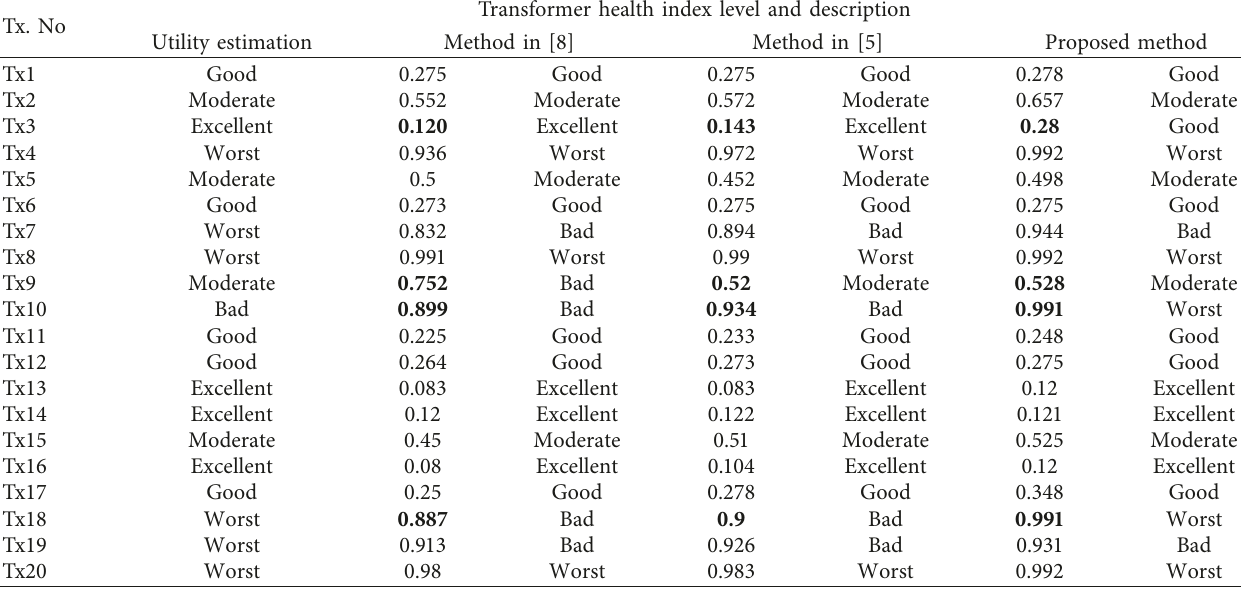
Table 7: Health index status by different methods for 20 different test